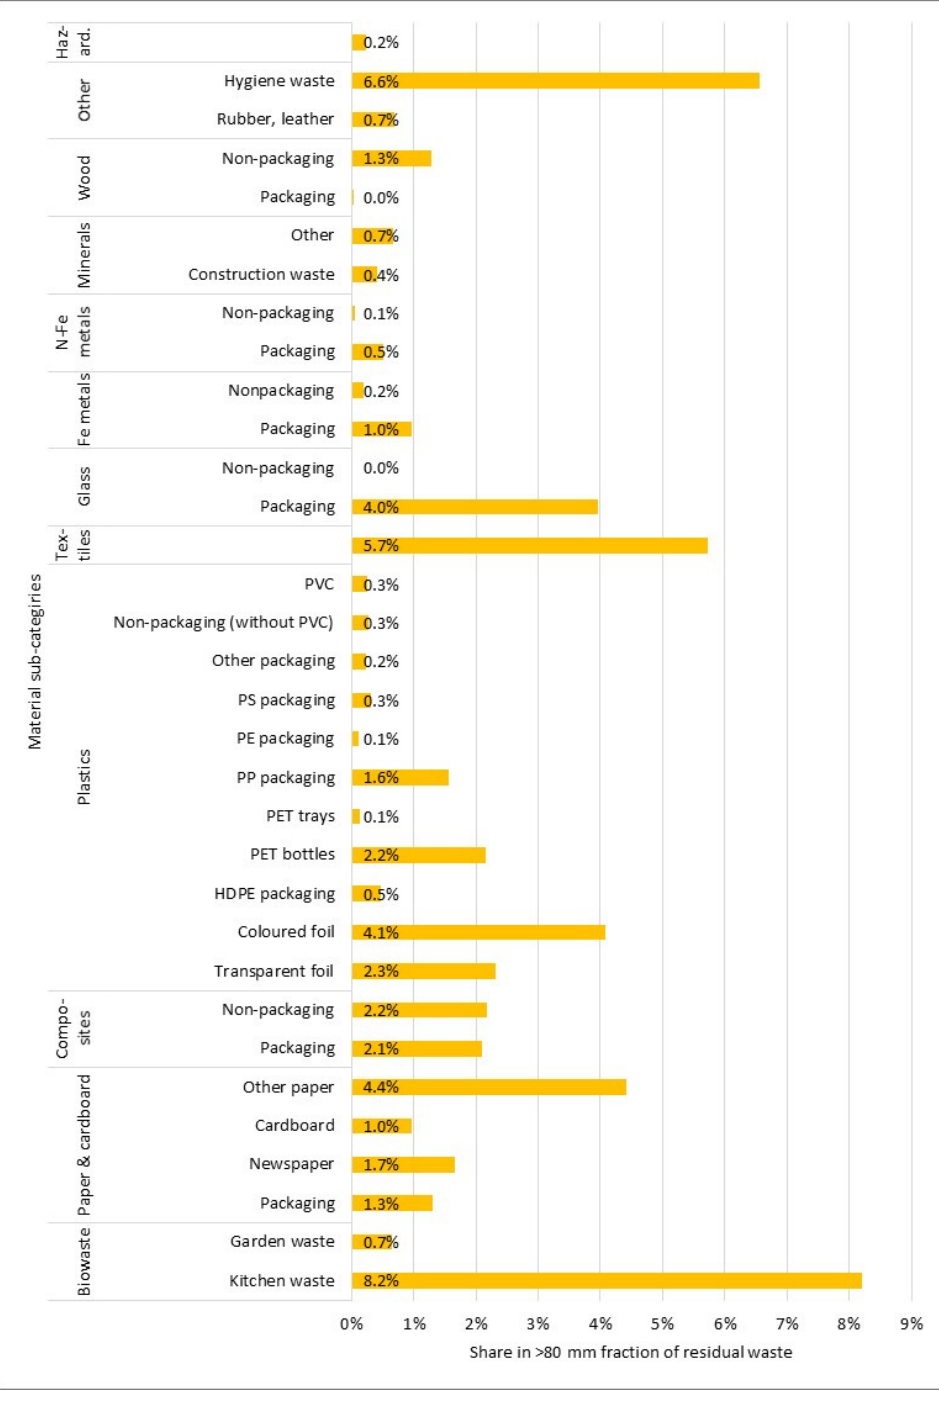
Figure 9. Composition of the >80 mm fraction of residual waste in Wroc ł aw by detailed categories.